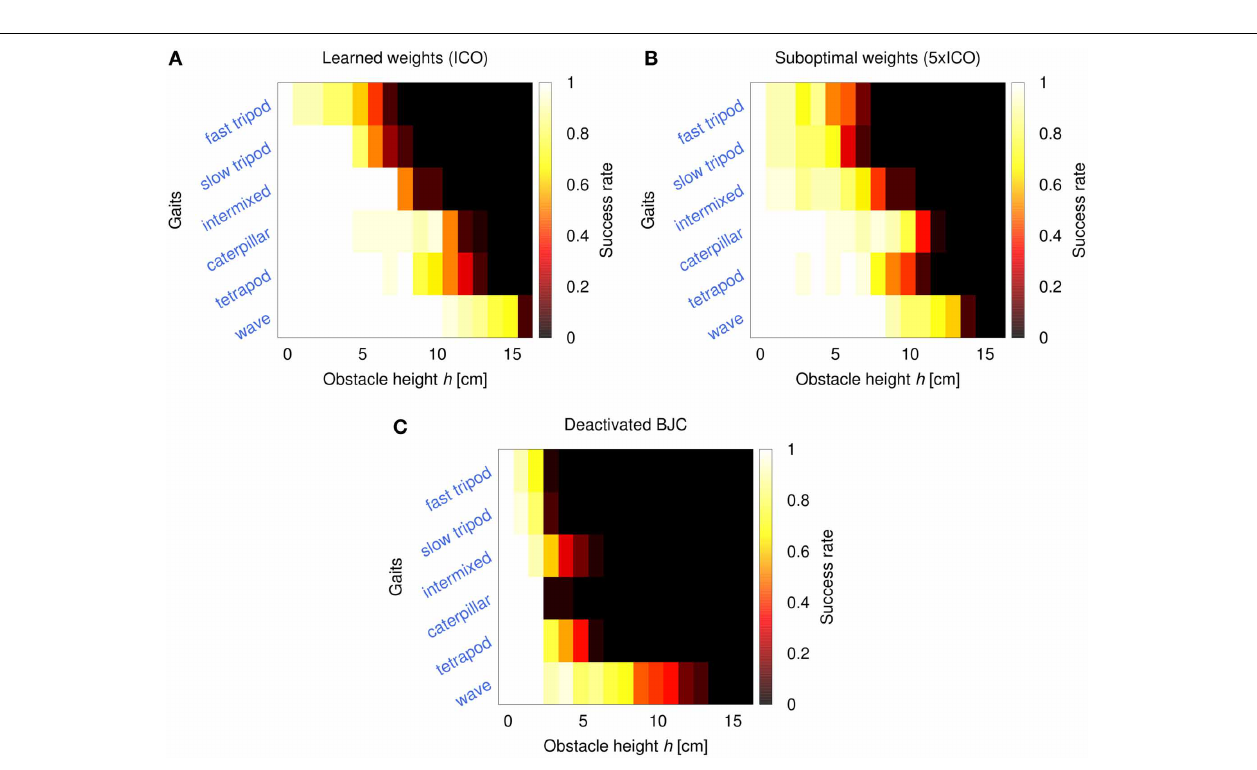
weights (5 × ICO), (C) and deactivated BJC. The performance is measured by the success rate of 20 trials. The robot is successful by traversing a 1m distance in a certain time ( t < 180s) with an obstacle on the